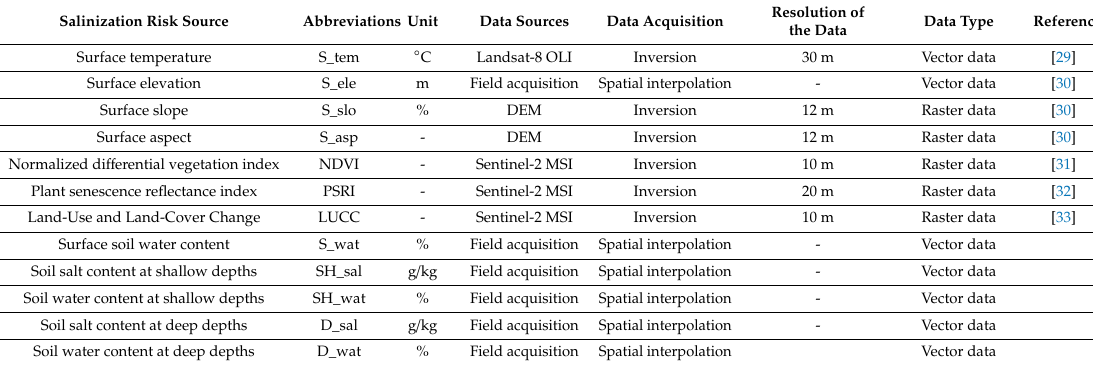
Table 2. Data acquisition of soil salinization risk sources in the study